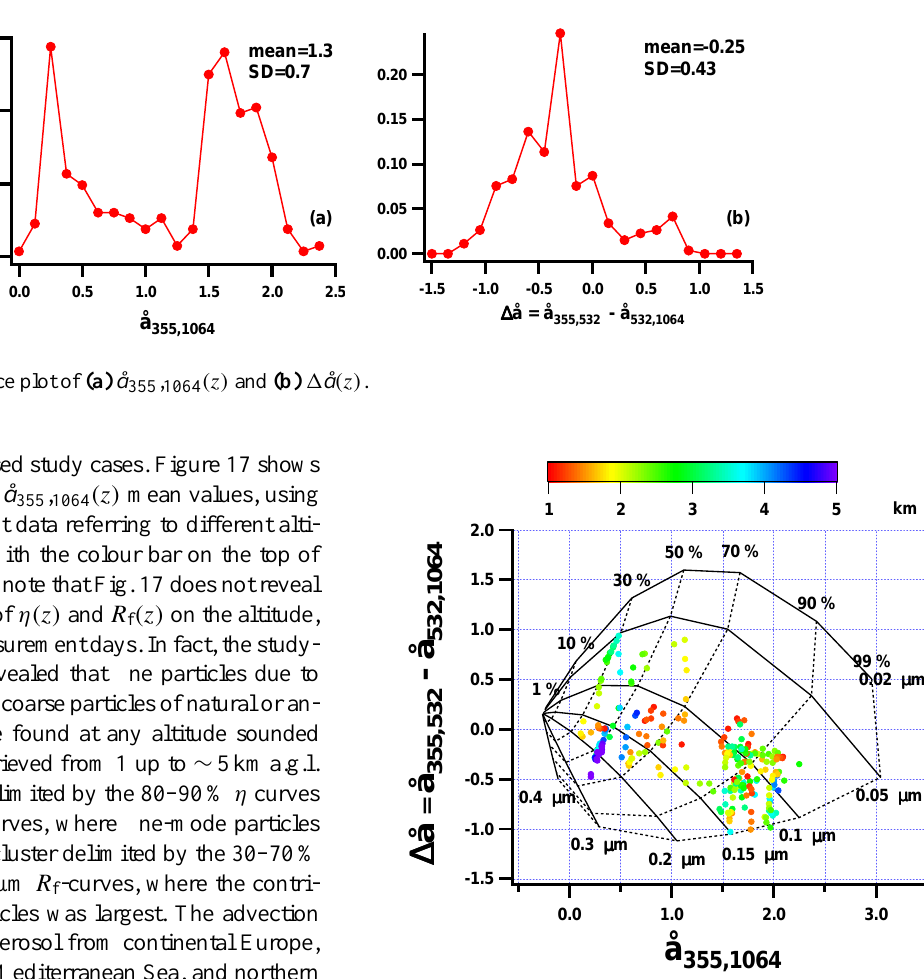
Figure 17 (M. R. Perrone et al.) 3